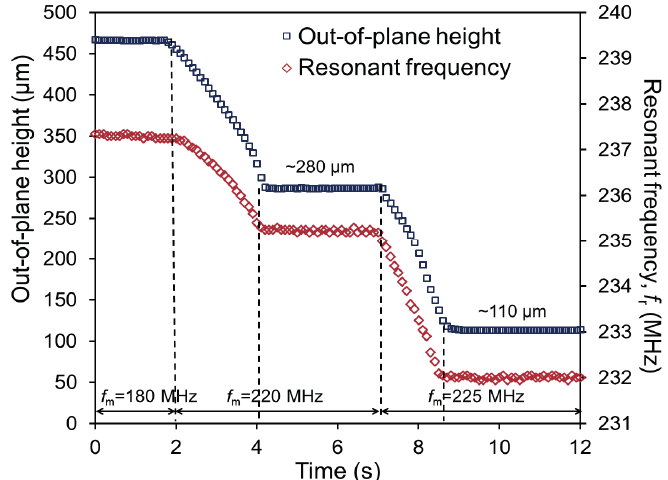
Figure 6. Wireless resonant tracking of f and measured actual displacement of the actuator r (180 MHz , 220 MHz and operated with varying f m